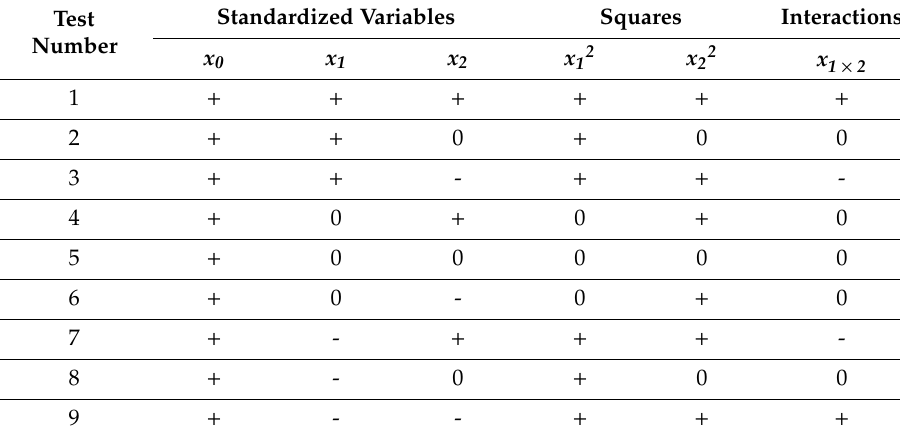
Figure 9. Methodology for measuring surface roughness and topography. Table 5. Studies’ plan matrix PS / DK 3 2 .